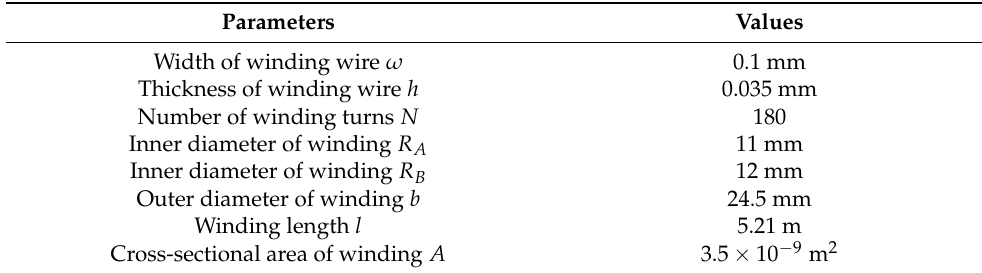
Table 1. Winding parameters of